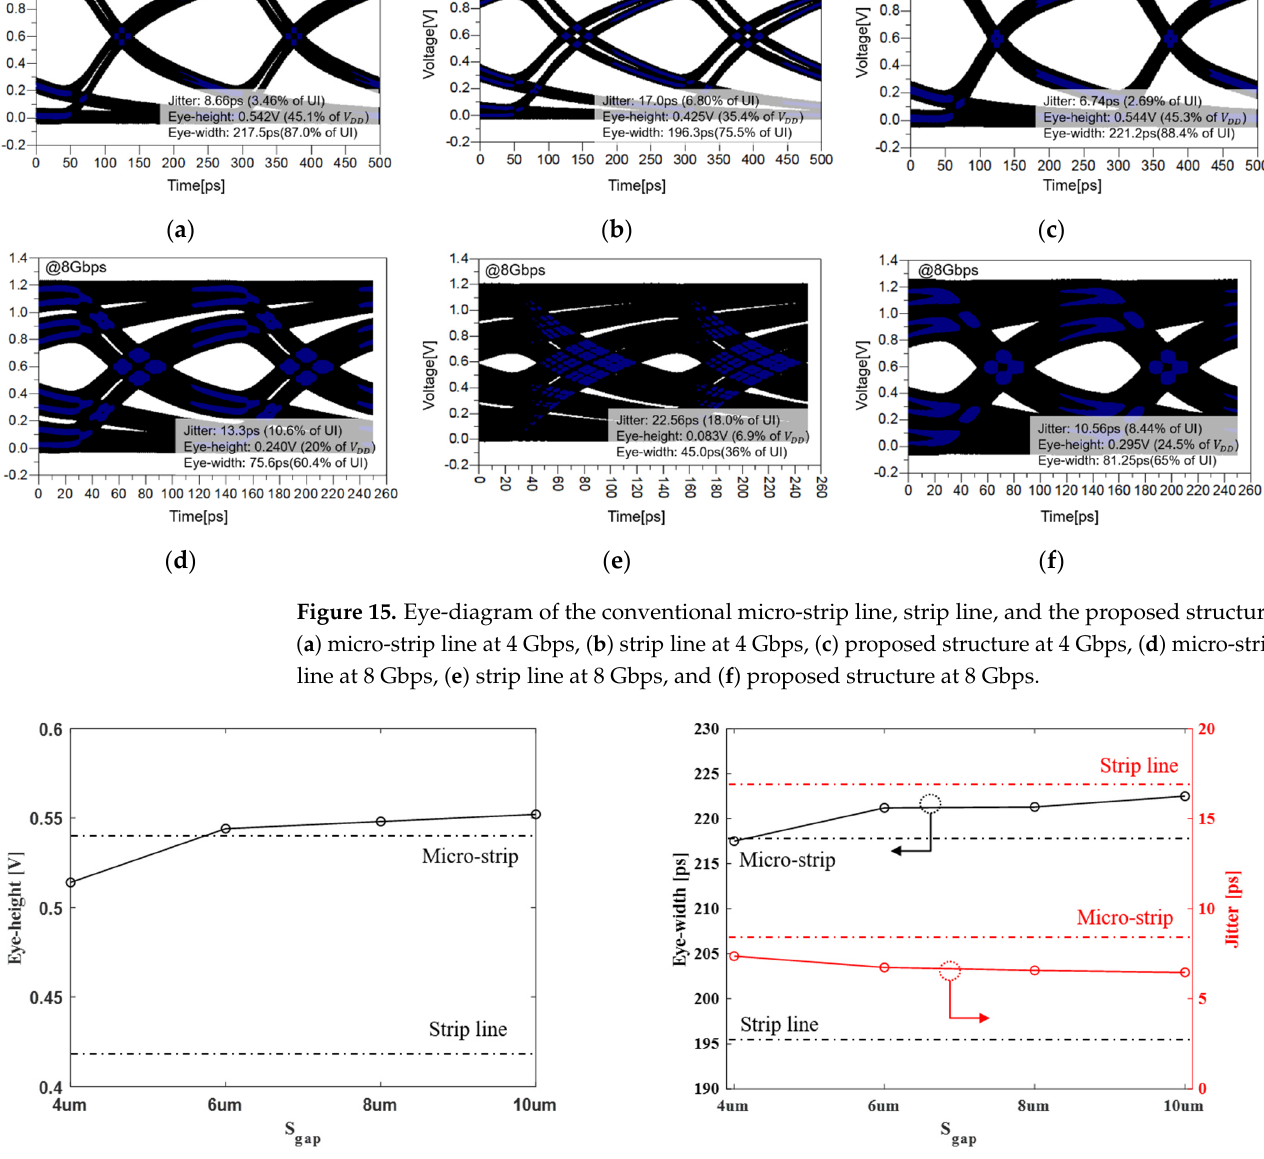
Figure 15. Eye-diagram of the conventional micro-strip line, strip line, and the proposed structure: ( a ) micro-strip line at 4 Gbps, ( b ) strip line at 4 Gbps, ( c ) proposed structure at 4 Gbps, ( d ) micro- strip line at 8 Gbps, ( e ) strip line at 8 Gbps, and ( f ) proposed structure at 8 Gbps. At 4 Gbps, the proposed channel structure can improve eye width, eye height, and